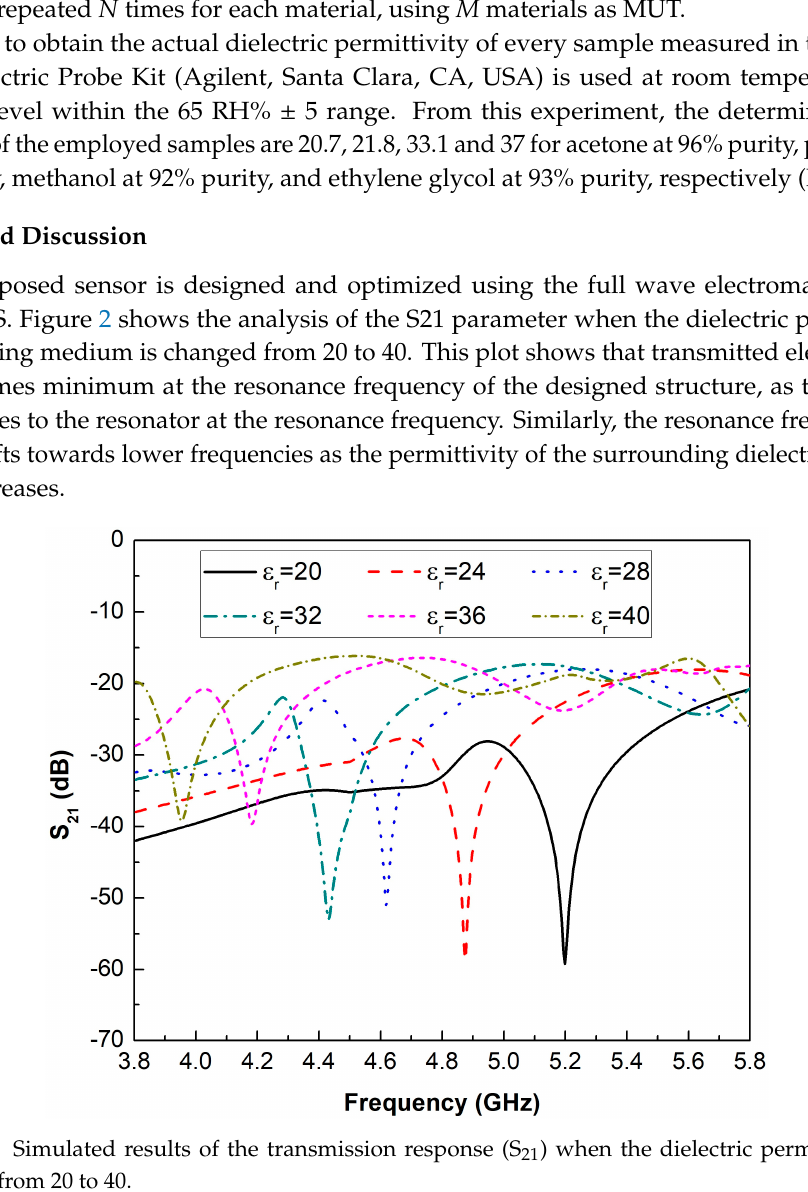
Table 1. Dimensions of the proposed sensor based on a monopole-coupled SRR.